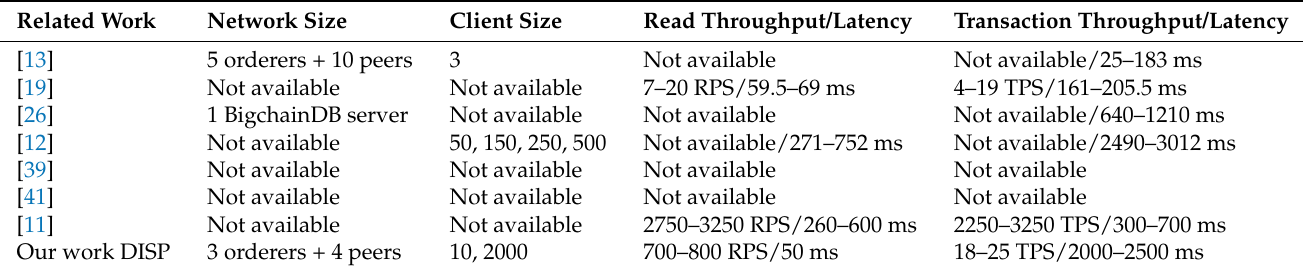
Table 3. Performance comparison of the proposed platform to related